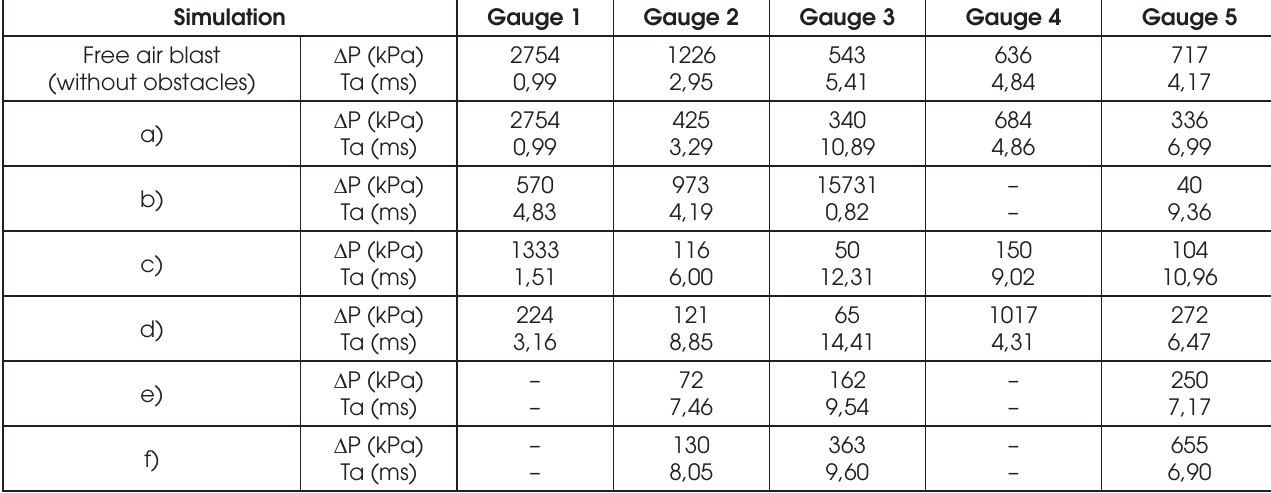
Results of the shock wave overpressures and the arrival time